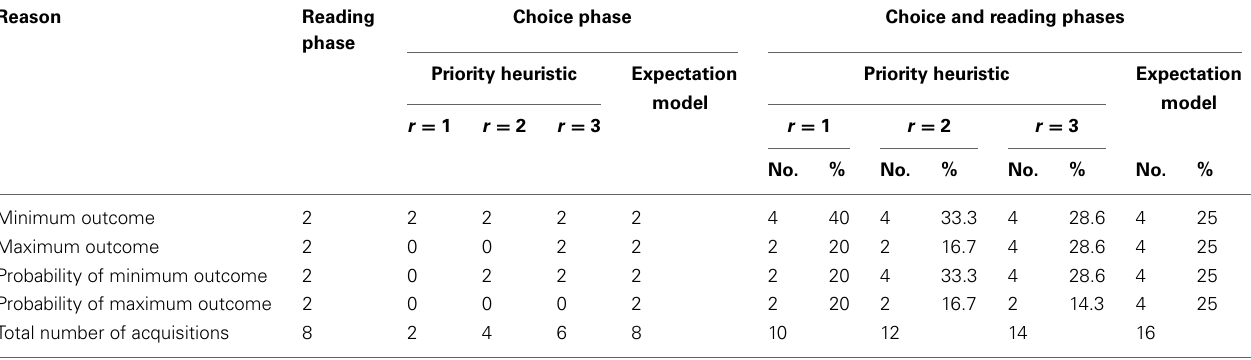
Table A1 | Derivation of the predicted relative acquisition frequencies.